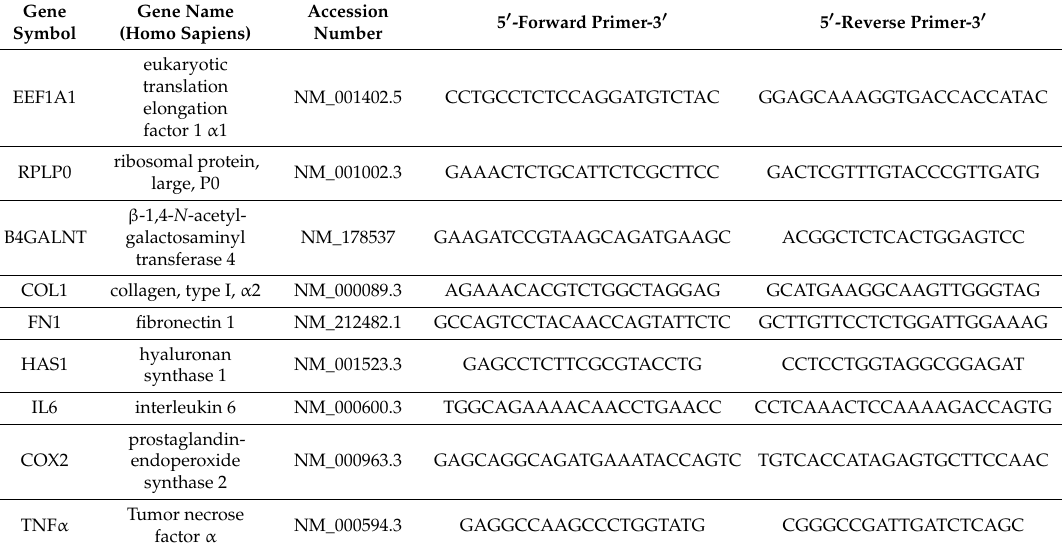
Table 1. Reference and target genes used for